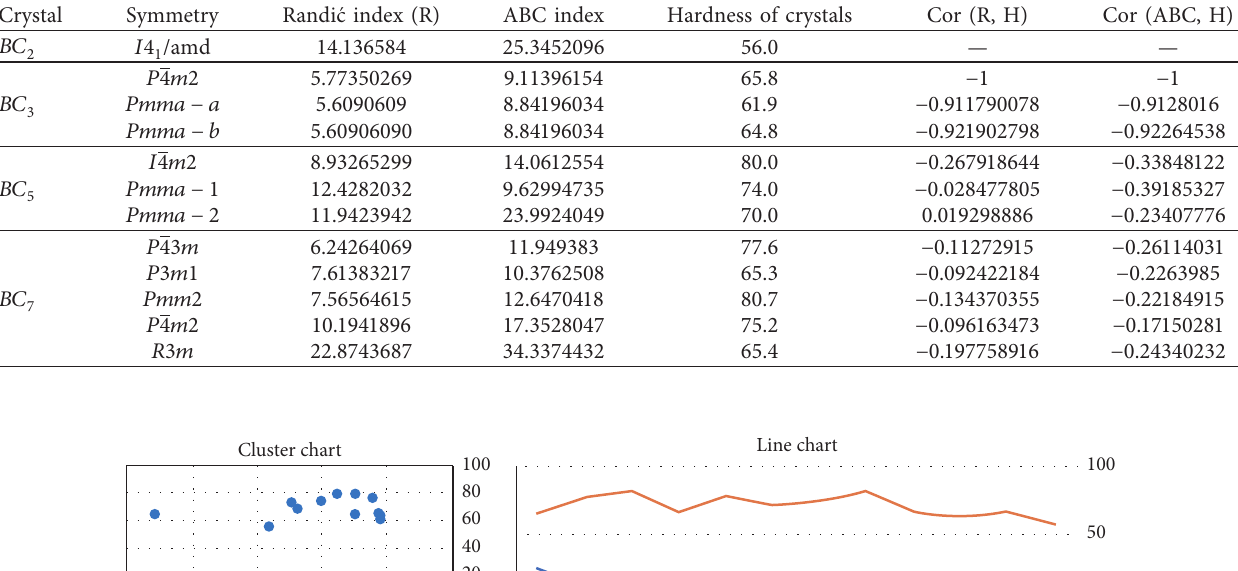
Table 3: Structure symmetry, Randi´c index (R), atom-bond connectivity (ABC) index, calculated hardness (H), and their cumulative correlations (Cor) between (R, H) and (ABC, H).